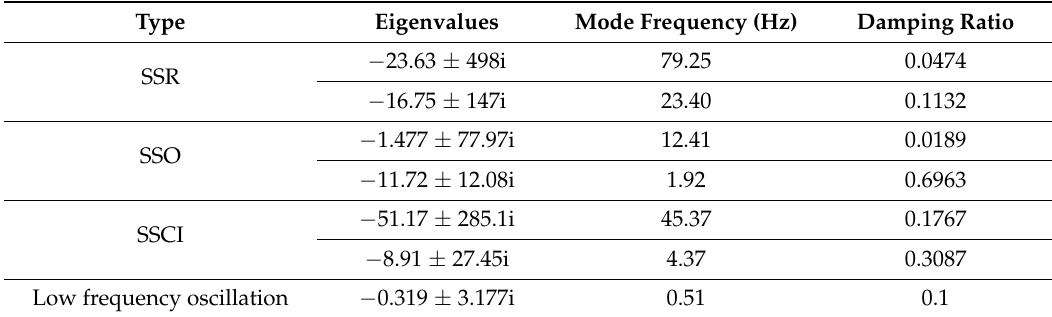
Table 1. Eigenvalues of DFIG connected to grid.